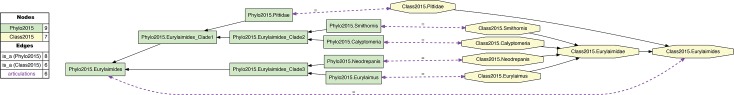
Input visualization of the alignment of the phylogenomic reconstruction of passeriform clade concepts sec. 2015.PEA–prefixed with "Phylo2015"–with the corresponding classification concepts sec. Gill & Donsker (2015) [20]–prefixed with "Class2015".The phylogenomic topology renders that of Class2015.Eurylaimidae paraphyletic, and hence the name "Eurylaimidae" is not represented in any clade concept label sec. 2015.PEA. See also Prum et al. (2015). See also S5 File.